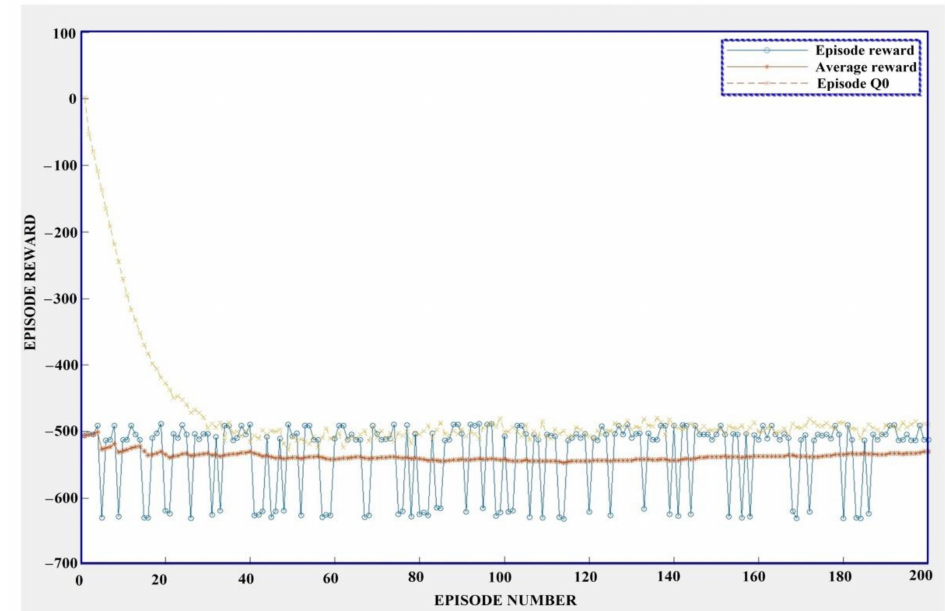
Figure 7. Training stage of the RL-TD3 agent for the correction of i qref .